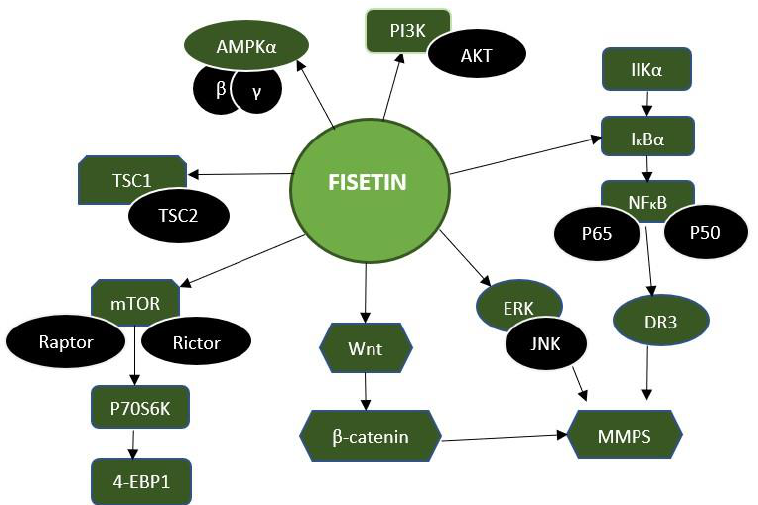
Figure 4. Molecular targets of fisetin. Fisetin inhibits the several signaling pathways, such as AMPK, PI3K, NF- κ B, Wnt, mTOR, and TCS1, and increases related mRNA expressions such as p50, P65, and JNK, which are associated with promoting the apoptosis mechanism inside the cells. Hence, fisetin increased the death of cancer cells, and reduced their proliferation.